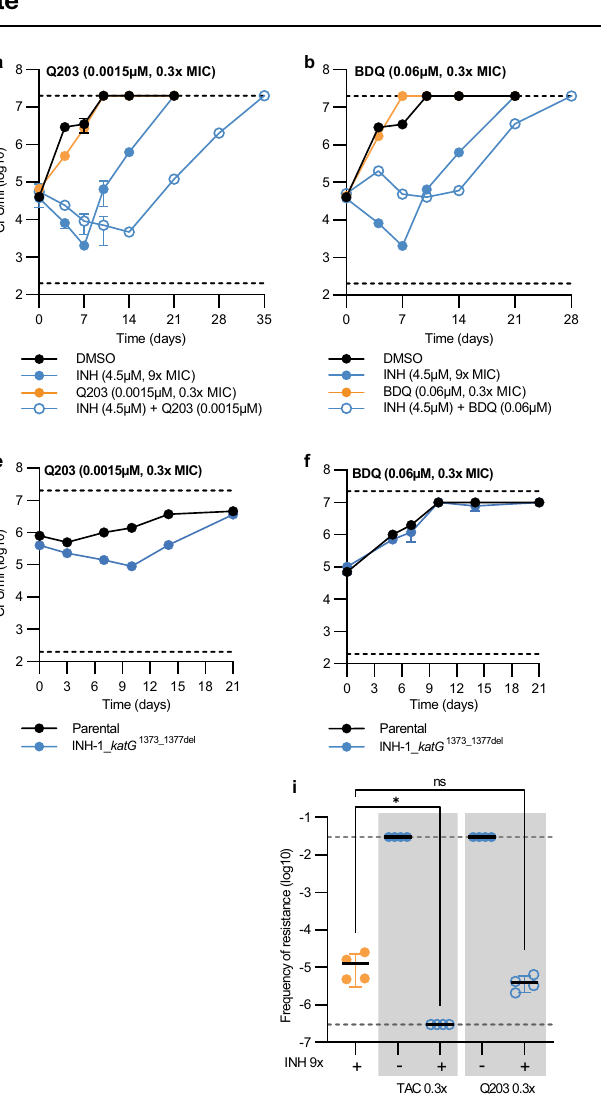
comparisons test (95% CI). For j , statistical signi fi cance was investigated using a one-way ANOVA, and corrected for multiple comparisons using the Bonferroni multiple comparisons test (95% con fi dence interval). For i , j ; ns=no signi fi cance, * P ≤ 0.05. For a – h , data are the mean±range of biological duplicates from a representative experiment ( n >2 independent experiments). For a – h , the DMSO and INH (9× MIC) CFU plot is repeated across all fi ve panels. For c , INH (9× MIC)+TAC (0.3× MIC) the biological duplicates are split into individual repli- cate plots as one replicate failed to evolve INH resistance. For i , j , data are the mean±SD of four biological replicates from a representative experiment ( n =2 independent experiments). DMSO represents solvent control. Dashed lines repre- sent upper and lower limits of